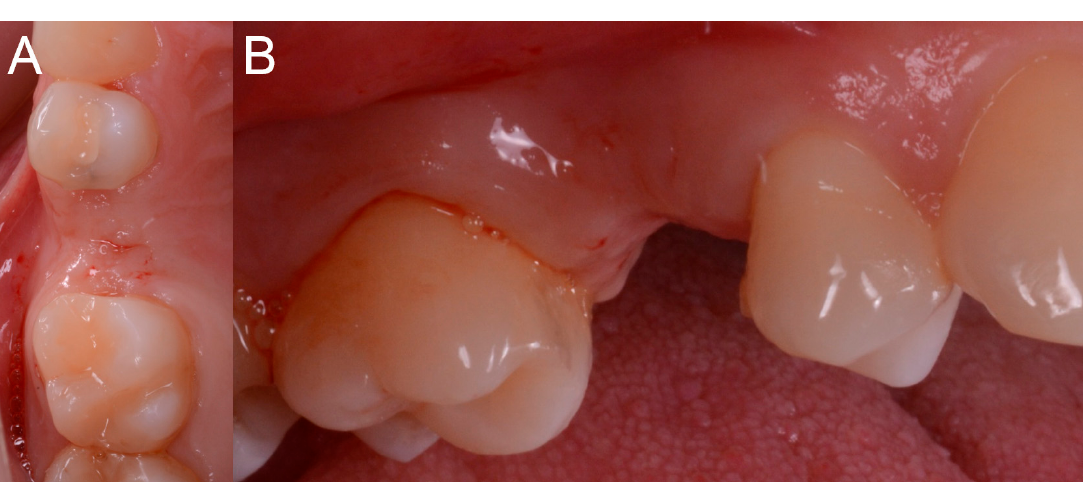
Figure 6. Pre-operative situation. ( A ) Occlusal view. ( B ) Lateral view.